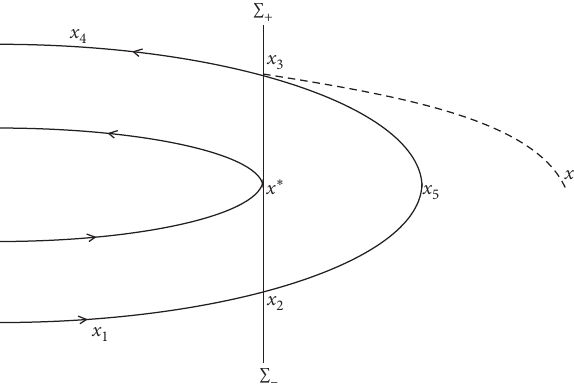
Figure 5: The sketch map of the zero-time-discontinuity mapping near the grazing